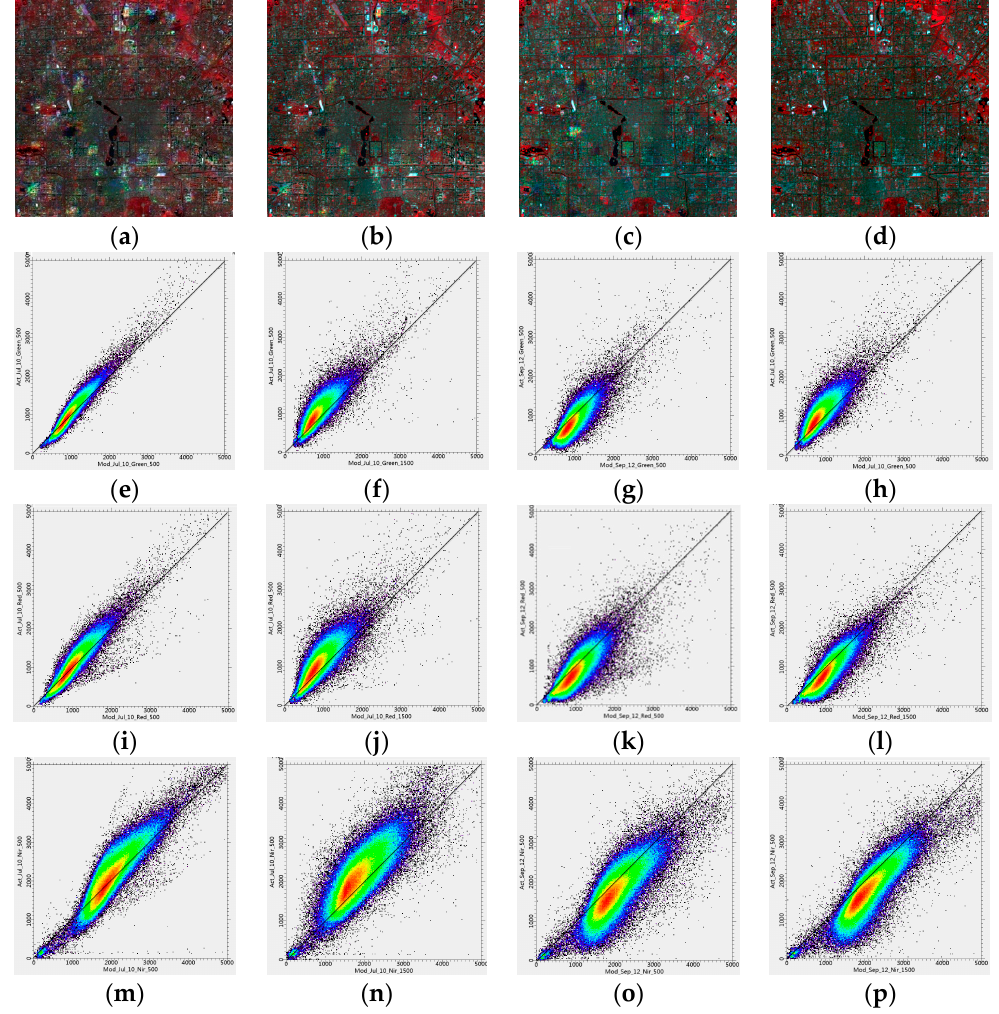
Figure 8. Proposed bi-directional fusion results with spatially extended training samples from the urban dataset: ( a – d ) the composited fusion results (NIR/red/green) modeled on 10 July and 12 September 2017 with training image sizes of 500 × 500 pixels and 1500 × 1500 pixels, respectively; and ( e – p ) the scatter plots of ( a – d ), which indicate the comparison among the green, red, and NIR bands of the modeled and actual reflectance.